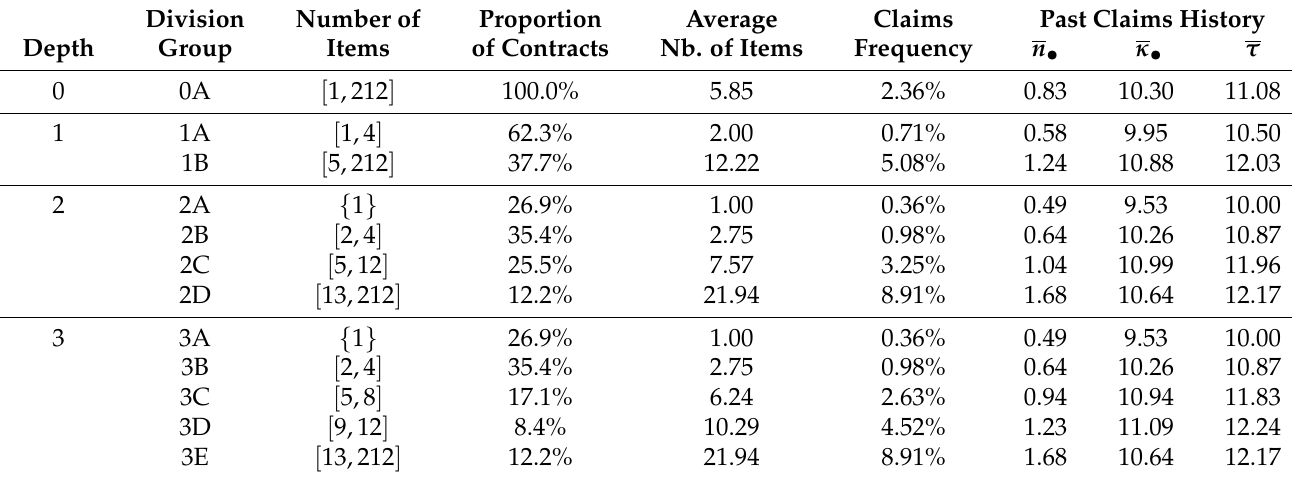
Table 4. Descriptive summary of each group of